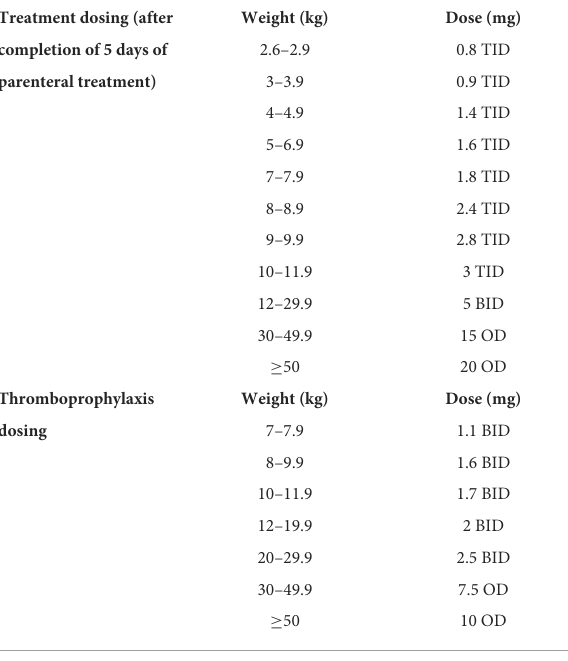
TABLE 3 Rivaroxaban dosing [modified from Young et al. (16) and Rivaroxaban package insert].